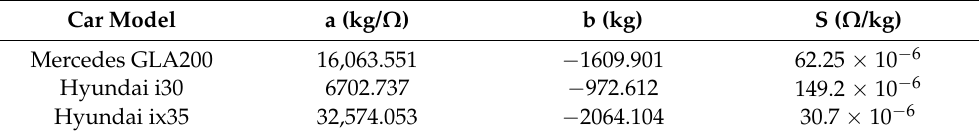
Table 3. The scaling factors (y = a x + b ) of load measurement system and sensitivities.